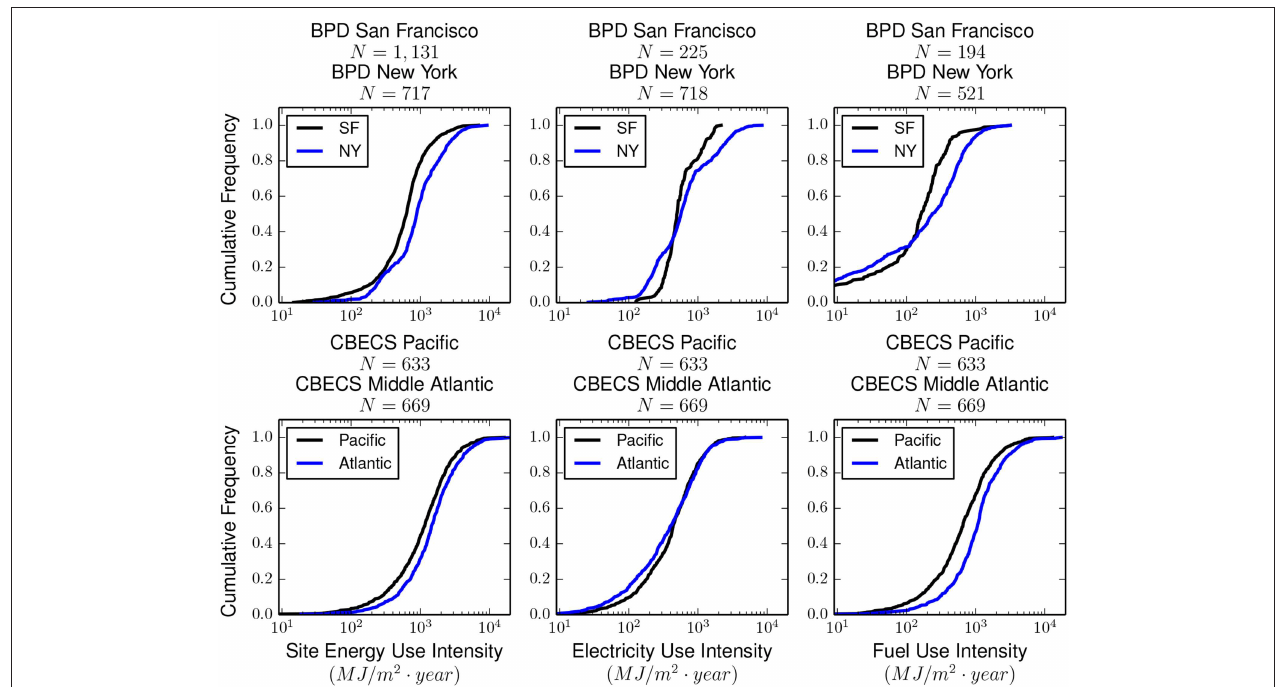
FIGURE 3 | Cumulative distribution of annual whole-building, electricity, and fuel energy consumption normalized by gross floor area ( MJ / m 2 ) for commercial buildings in San Francisco and New York in the Building Performance Database (BPD), and commercial buildings in the Pacific and Middle Atlantic census divisions in